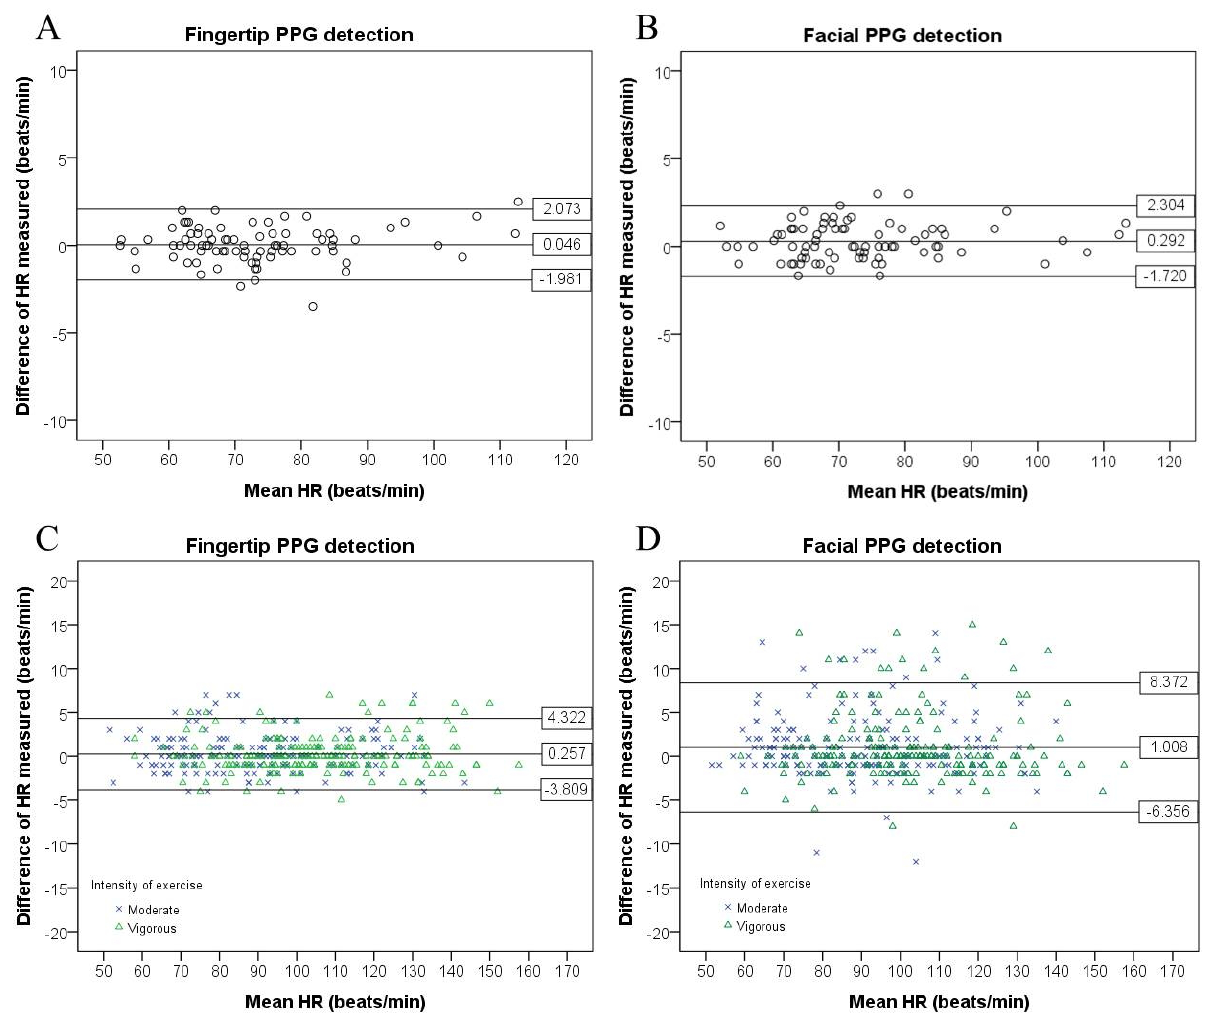
Figure 3. Bland-Altman plots of limits of agreement in resting heart rate (HR) estimated from the Cardiio smartphone app and a reference electrocardiogram (ECG). (A) Resting estimated HR from fingertip PPG signals. (B) Resting estimated HR from facial PPG signals. (C) Postexercise HR from fingertip PPG signals. (D) Postexercise HR from facial PPG